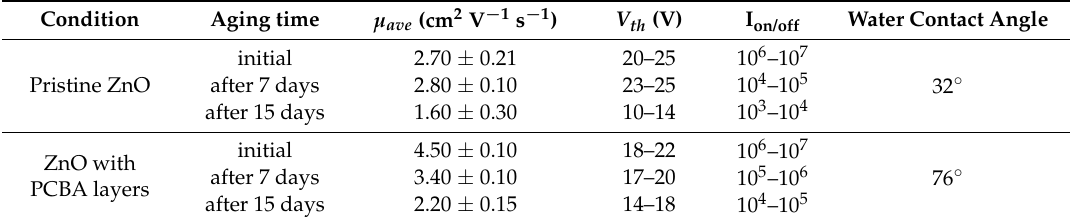
Table 1. The electrical characteristics of the pristine ZnO thin film transistors (TFTs) and the ZnO TFTs with 4-chlorobenzoic acid (PCBA) interfacial modification layers with Al electrodes. The average results are calculated based on 12 devices.